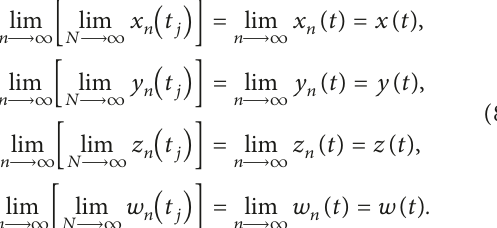
) in x − y − w space; ( c 3